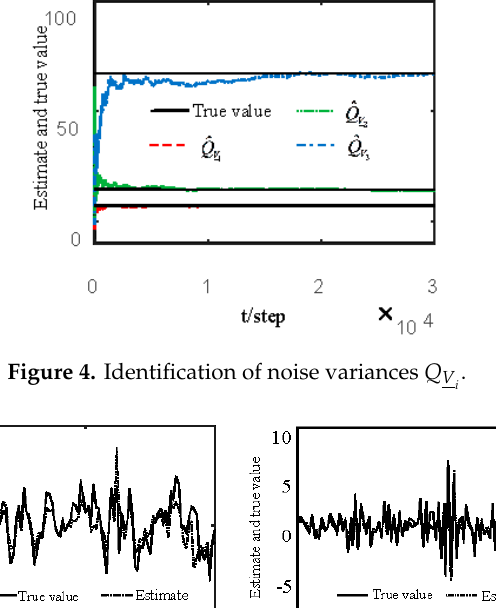
Figure 3. Identification of noise variance Q w .